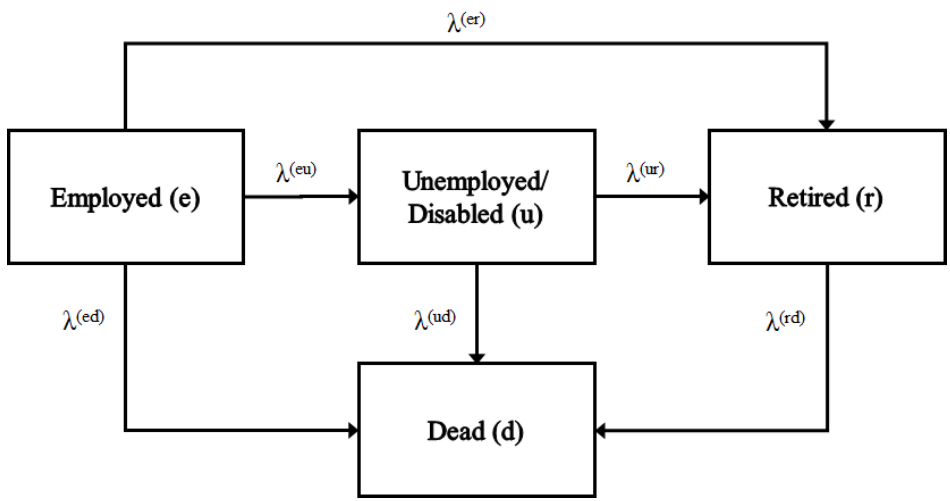
Figure 2. Markov chain of a life insurance and pension annuity